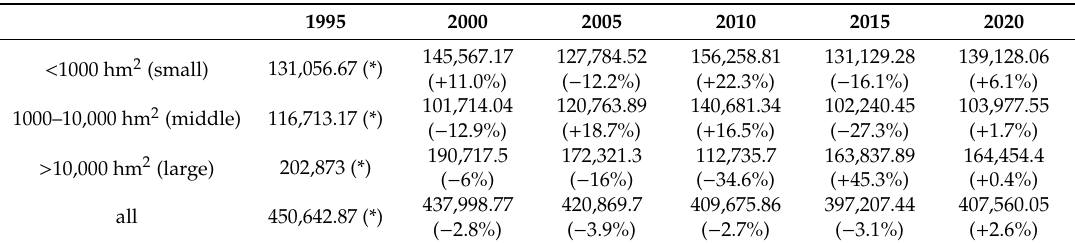
Table 6. The alpine wetland in the study area consisted of di ff erent patches, from 1995 to 2020.